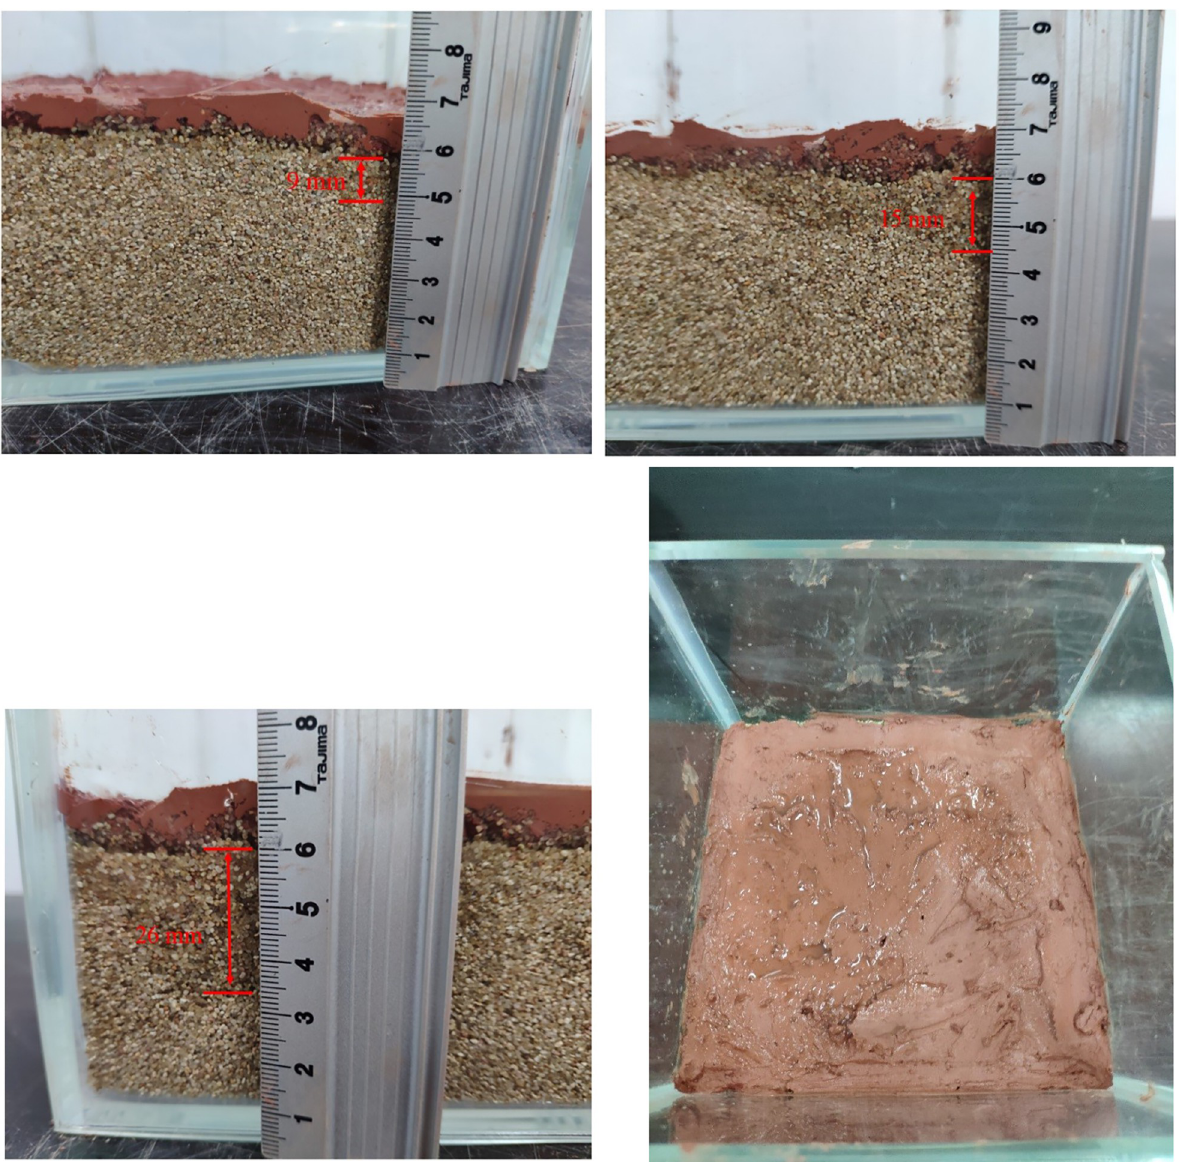
Fig 14. Infiltration of 8 mm thick naturally weathered red-bed soil films after dropping water (A) Water dropped on an 8 mm thick naturally weathered red-bed soil film for 3 m; (B) Water dropped on an 8 mm thick naturally weathered red-bed soil film for 6 min; (C) Water dropped on an 8 mm thick naturally weathered red-bed soil film for 9 min; (D) Water dropped on an 8 mm thick naturally weathered red-bed soil film for 12